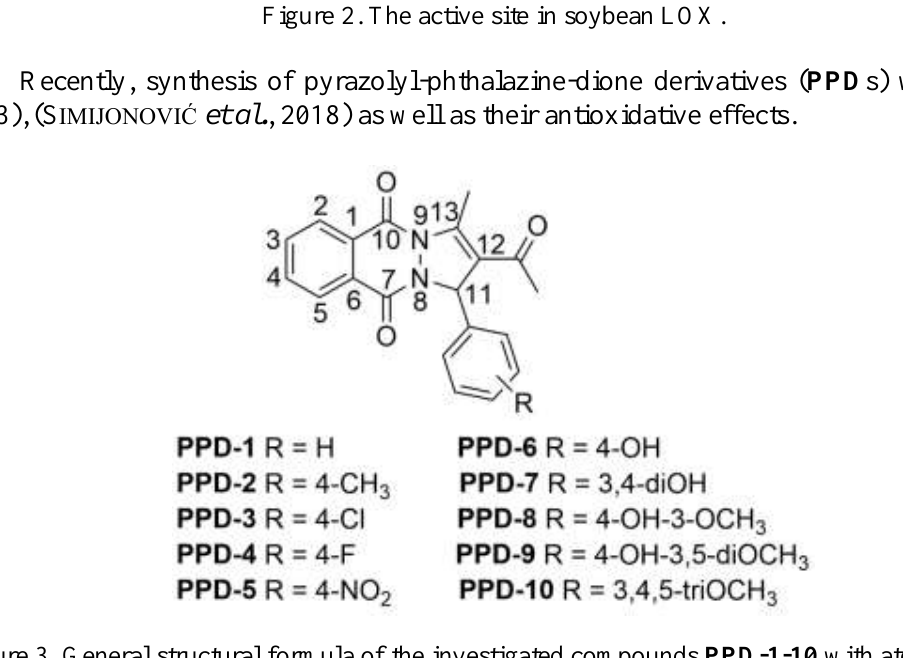
Figure 2. The active site in soybean LOX.